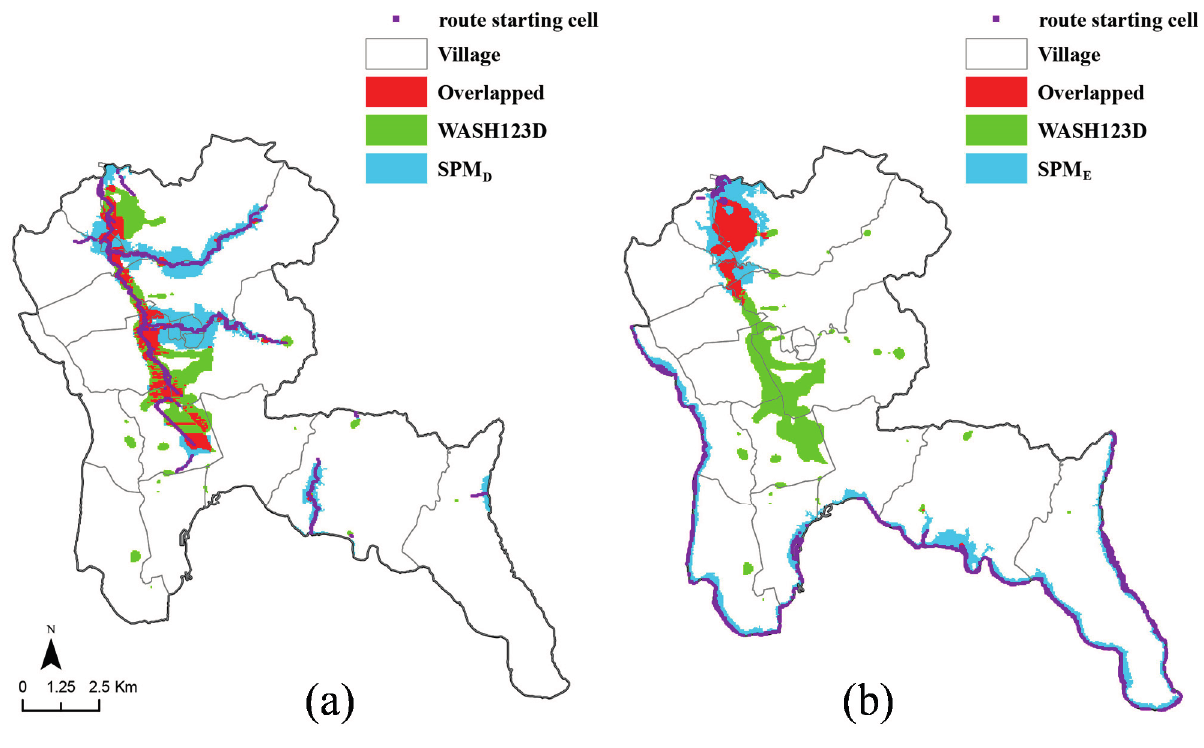
Figure 8. Overlapping flood areas at the grid level between WASH123D and SPM D ( a ) and SPM E ( b ) in Hengchun.